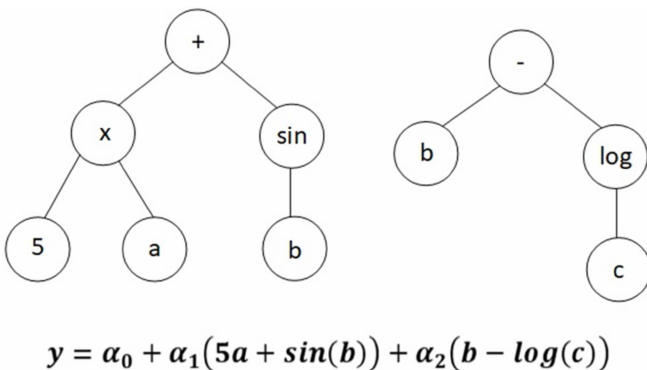
Figure 3. Illustration of a Multi-Gene model (adapted from